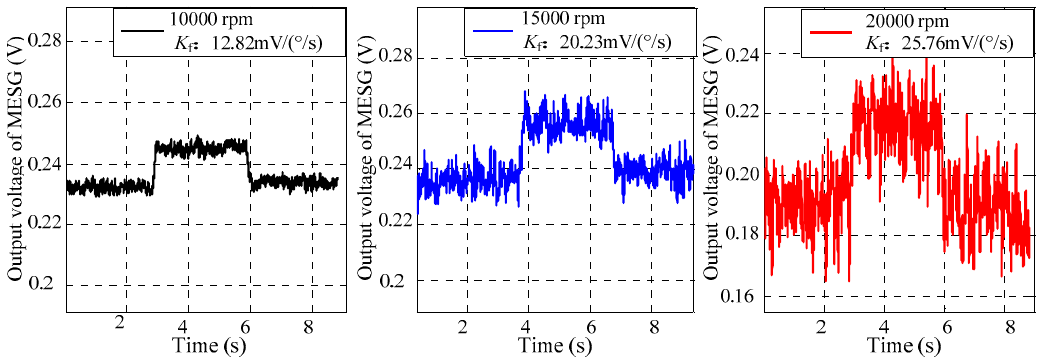
Figure 5. Scale factor tests of MESG at different settings of the spin rate.